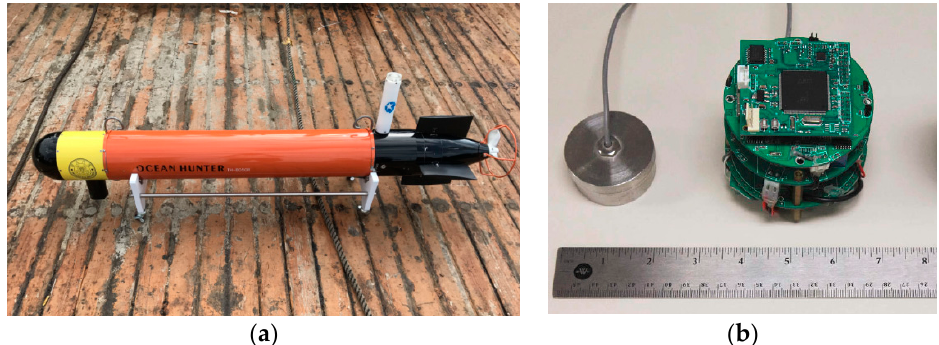
Figure 10. The autonomous underwater vehicle (AUV) and the acoustic modem module ( a ) The TH-050B AUV ( b ) The acoustic modem module.